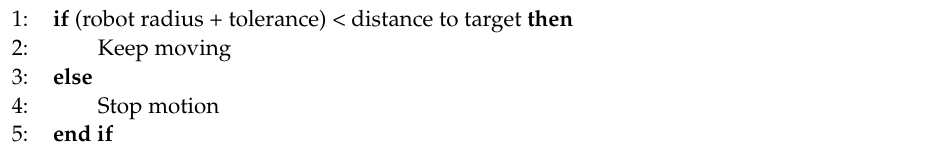
Algorithm 1 Solution: The area occupied by individuals in space